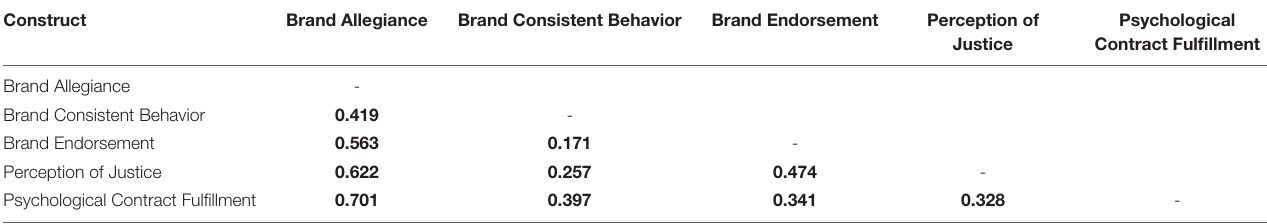
TABLE 4 | Discriminant validity (HTM ratio).